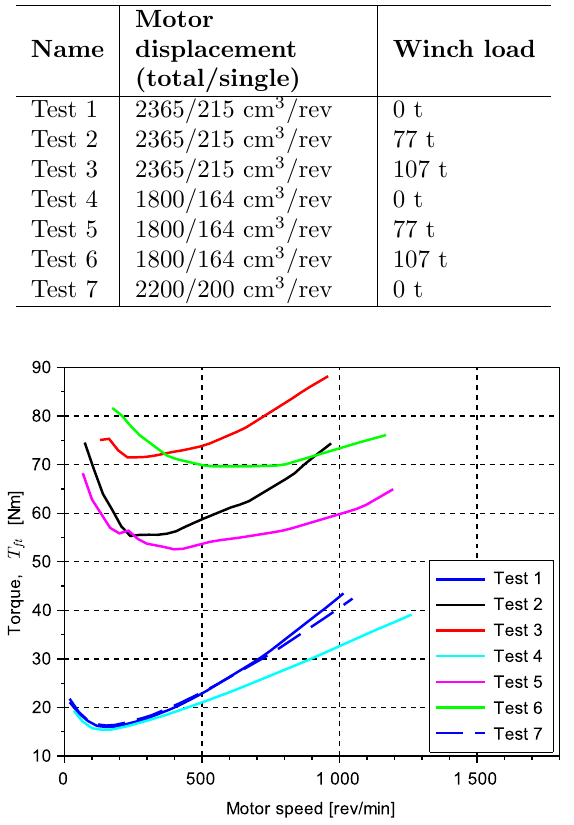
Figure 7: Calculated total winch friction based on